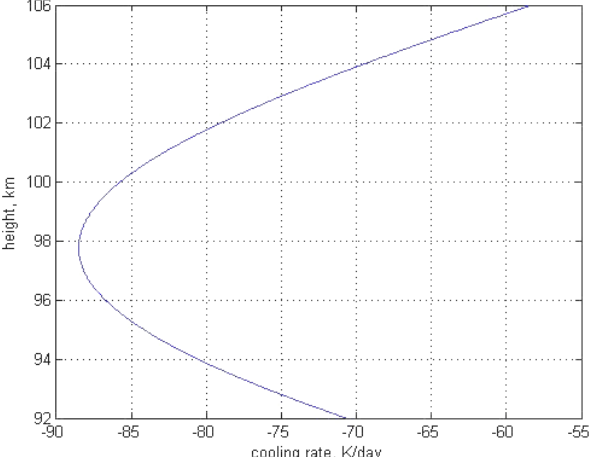
Fig. 6d. Height profiles of the cooling rate calculated with K eh = = ed K ed inferred from the [He] distribution at polar summer solstice = 5 × 10 6 cm 2 s − 1 , s = 0 . 002km − 2 , c = 0 . 4, P = 2, z m = ( K m ed